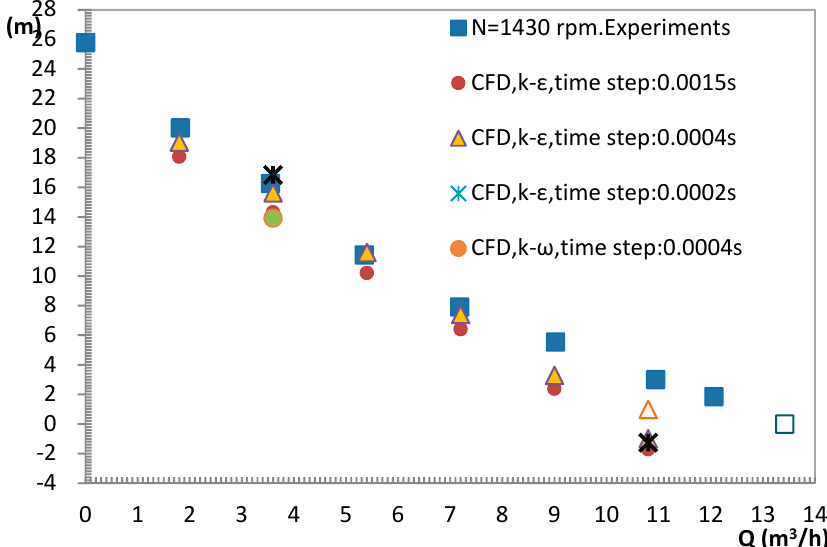
Figure 12. Comparisons between experimental and CFD results. N = 1430 rpm.